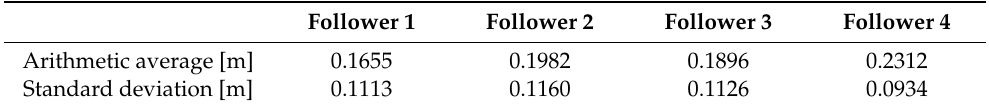
Figure 10. The 3D position of the drones relative to the leader at different speeds during flight around the perimeter of the rectangle: ( a ) 1.7 m/s; ( b ) 2 m/s; ( c ) 275 m/s. It can be noticed in the attached graphs that at the speeds of 1.7 m/s and 2 m/s, the tracking drones did not lose the leader over the entire route, while at the speed of 2.75 m/s, four out of five tracking attempts ended the marker being lost from sight (Table 6). Table 6. The average distance and standard deviation between the follower and leader routes at a speed of 1.7 m/s during flight around the perimeter of the rectangle.